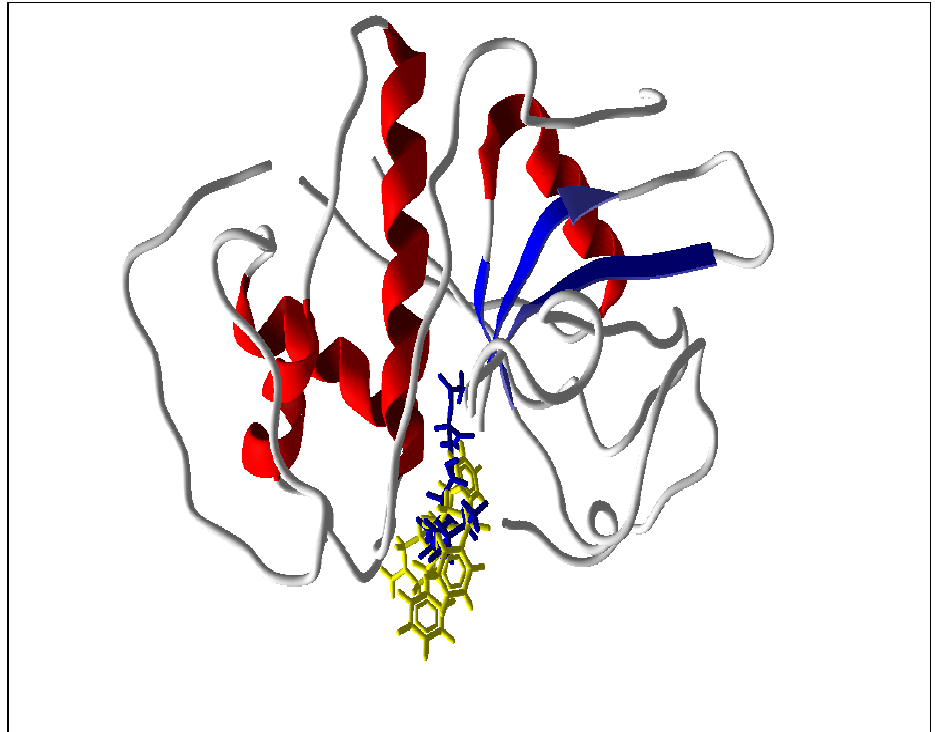
Supplementary Figure 3. Superposition of 8-hydroxylheptadeca-4,6-diyn-3-yl acetate (Blue) on K777 (Yellow) along the cleft of rhodesain.